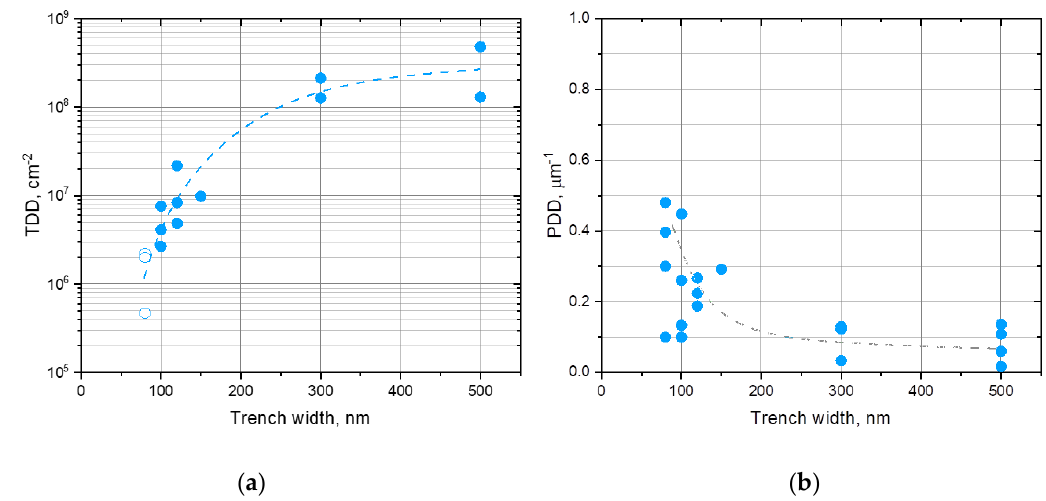
Figure 3. Threading dislocation density ( a ) and planar defect density ( b ) of GaAs nano-ridges as a function of underlying trench width based on electron channeling contrast imaging (ECCI). The open data points indicate that no threading dislocation was found, and the threading dislocation density (TDD) value, which was defined by the investigated surface area, is only an upper limit.